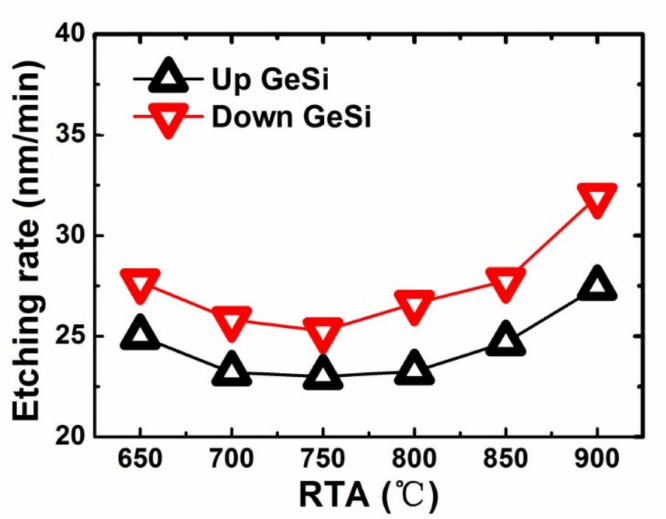
Figure 5. The etching rates of the top and bottom GeSi layers as a function of different RTA